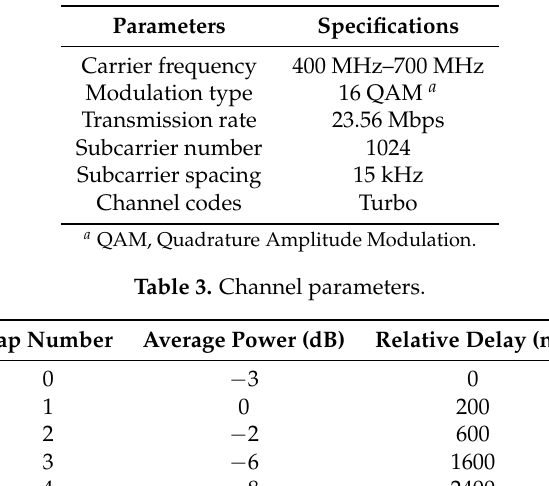
Table 2. Transmission parameters.